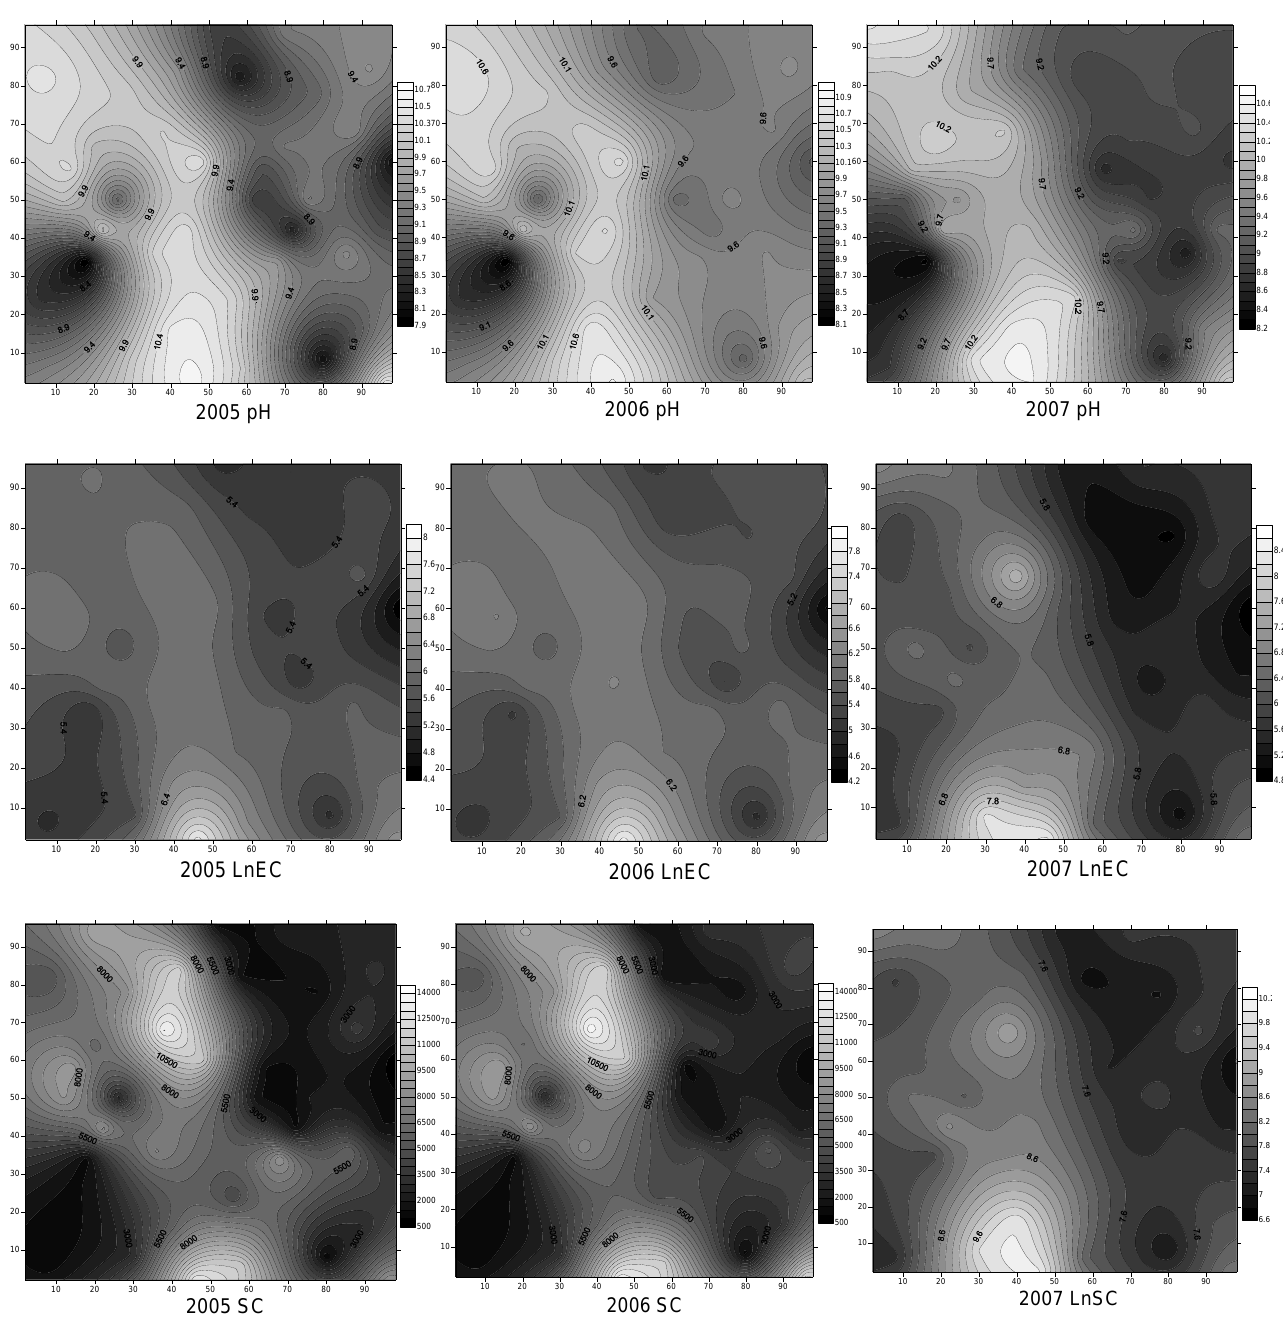
Figure 3. Maps of kriging estimations of four salinization parameters. SC is soil